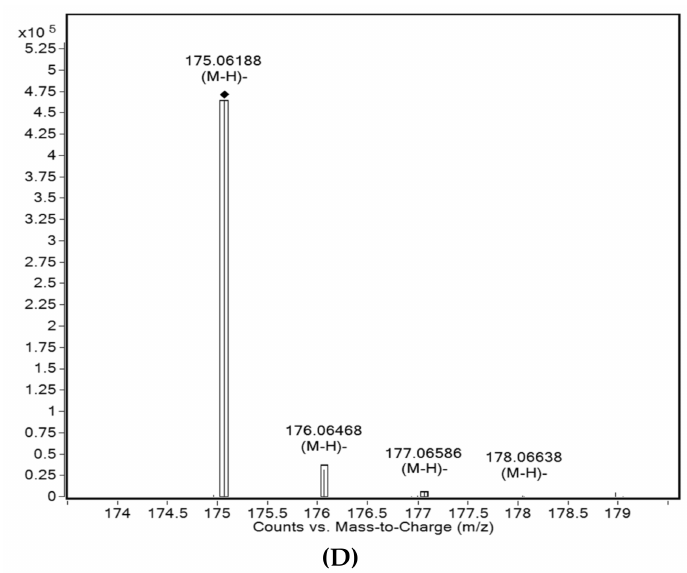
Figure 4. MS/MS spectra of 2-Isopropylmalic acid at average collision energies (10, 20, 40 eV) of: a pure analytical standard ( A ); and in the urine sample ( B ); extracted ion chromatogram (EIC) ( C ); and Find by Formula spectrum ( D